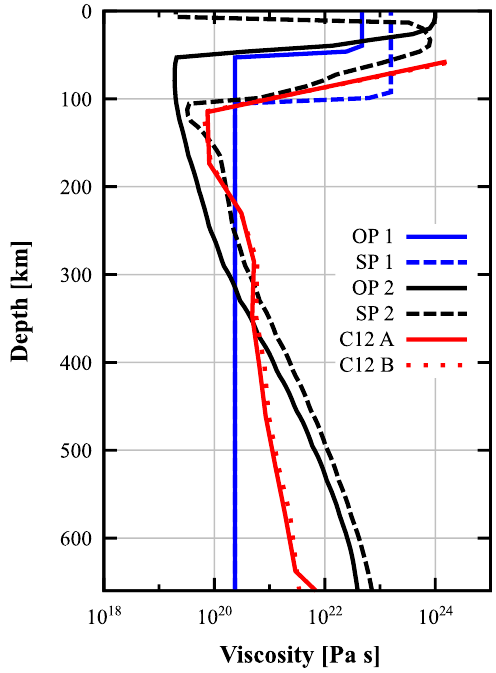
Figure 16. Viscosity profiles at 0Myr for the OP (at x = 2700km) and SP (at x = 2200km) of models 1 and 2. For comparison, the viscosity profiles derived by Cizkova et al. (2012) are